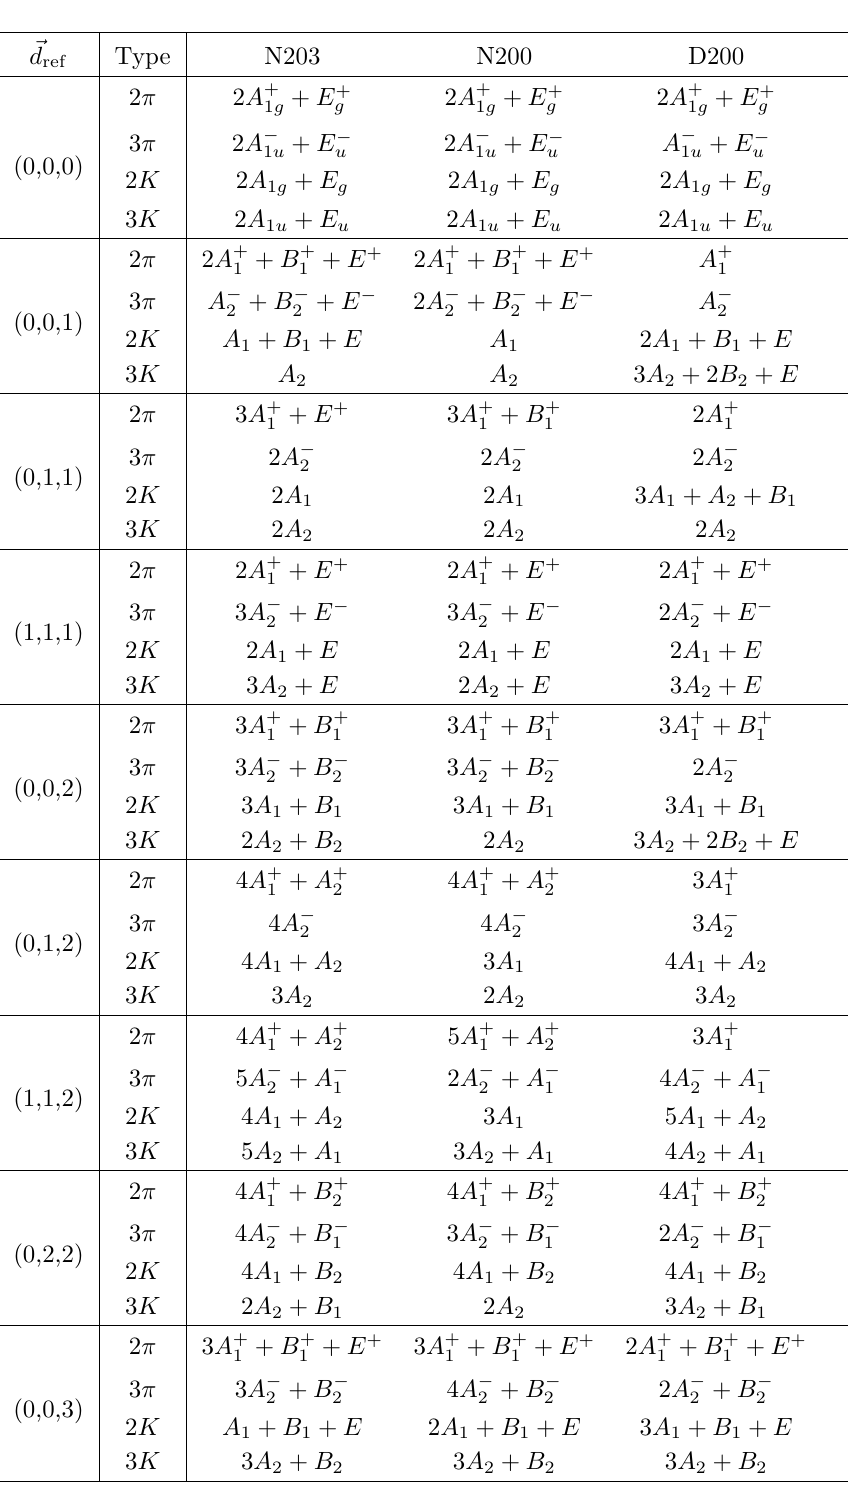
Table 32. Energy levels used in the fits of this work. Notation is as follows: “ 2 A − the lowest two levels in the A −